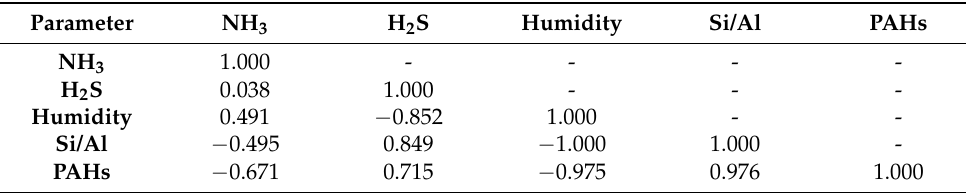
Table 11. Correlation between the different measured parameters.